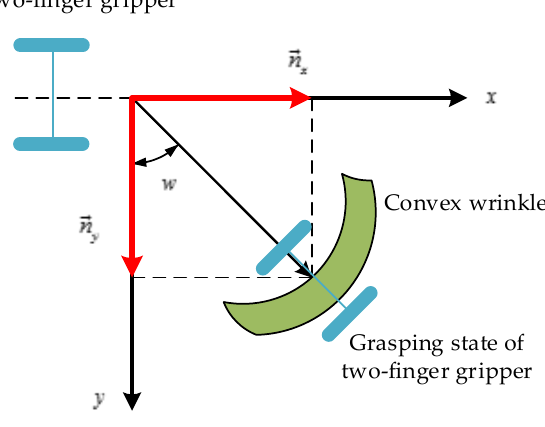
Figure 8. The grasp orientation of the method.